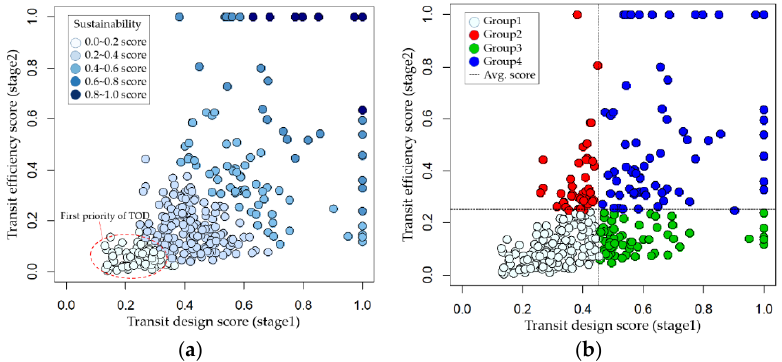
Figure 4. Efficiency evaluation results with respect to design and efficiency: ( a ) efficiency results prioritized regarding TOD; and ( b ) group-wise efficiency results.